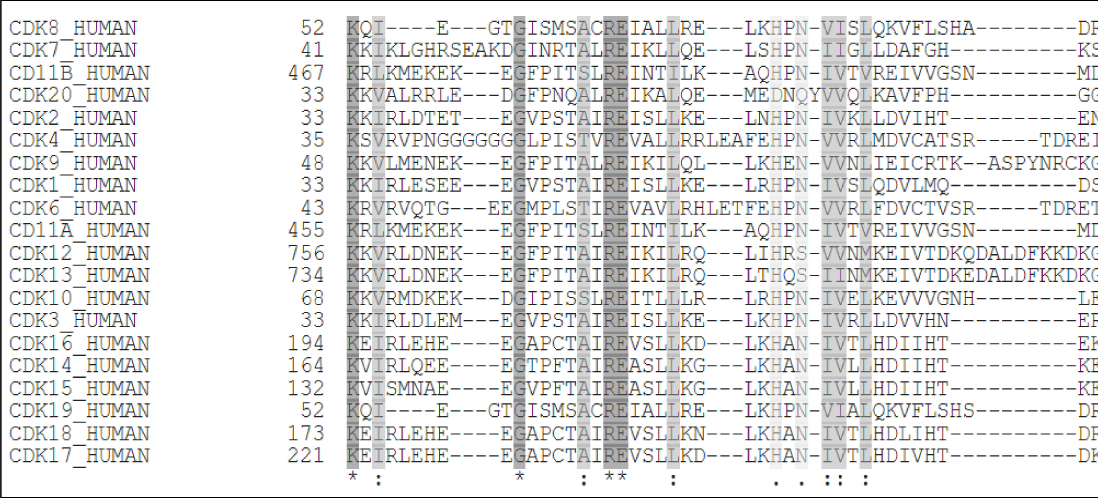
Figure 1. The PITALRE (Pro-Ile-Thr-Ala-Lue-Arg-Glu) sequence of CDK9 which aligned with the highly conserved PSTAIRE box, observed in multiple CDKs.